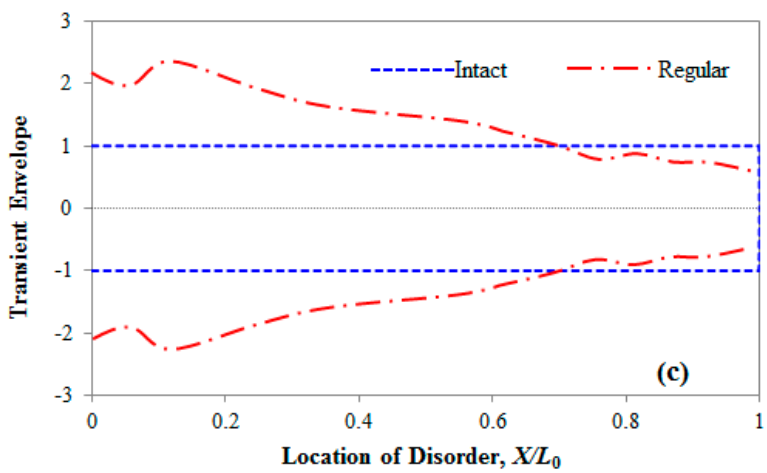
Figure 9. Results of the pressure wave envelope for regular disorder cases: ( a ) λ w /2 λ b = 1 and δ A = 0.05; ( b ) λ w /2 λ b = 1 and δ A = 0.10; and ( c ) λ w /2 λ b = 1 and δ A = 0.20.